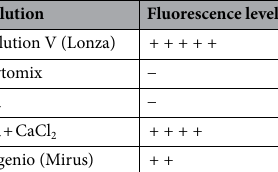
Table 1. Comparison of electroporation efficiency using the D-023 program in Amaxa Nucleofector II among electroporation buffers.